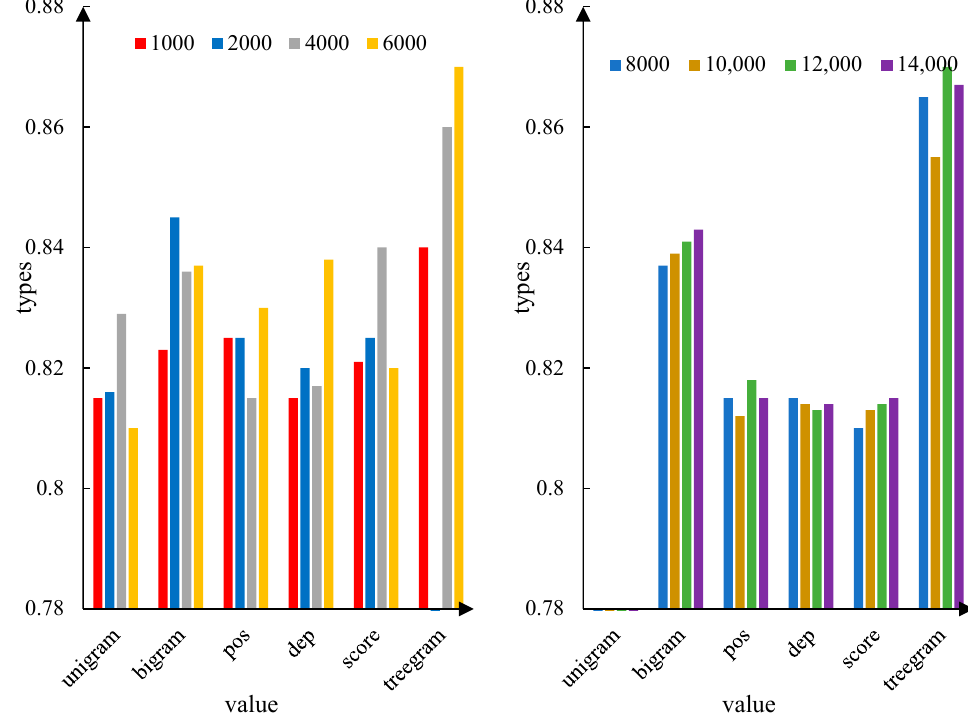
Figure 6. DBN: X600-300-100 classification standard rate.